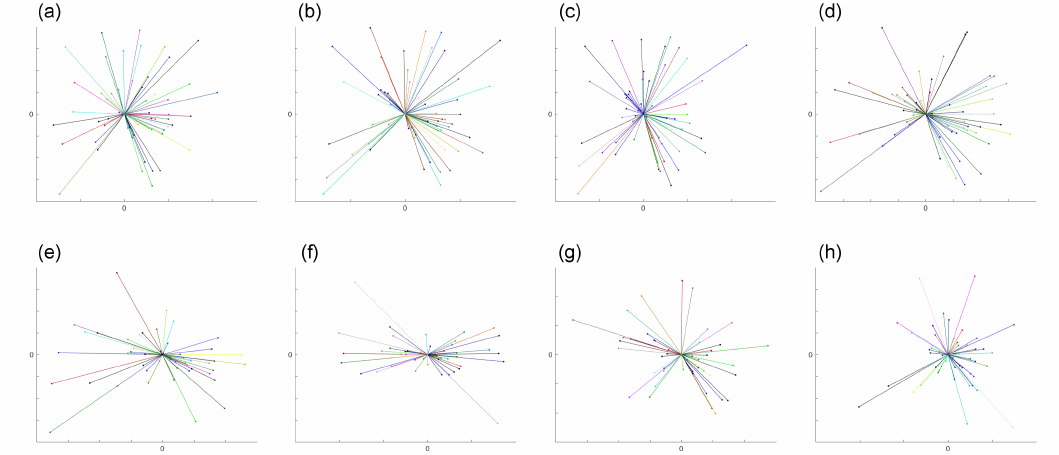
Figure 4. The plots demonstrate graphically the random walk cell migration patterns from Dataset 1 obtained from ( a – h ) with time step intervals 30-s, 1-, 2-, 3-, 5-, 7.5-, 10-m and 15-min, respectively.